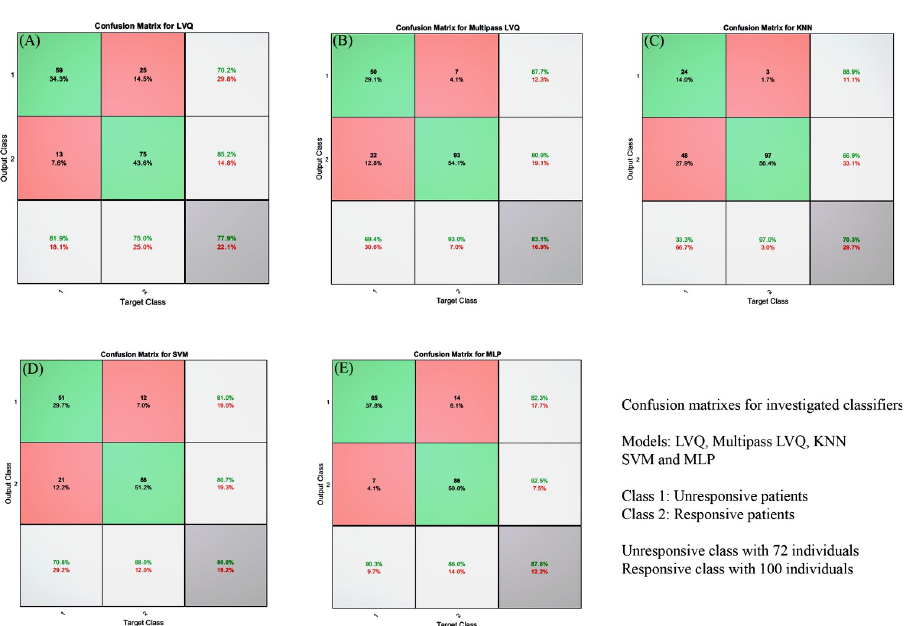
Fig 5. A, Confusion matrix for learning vector quantization neural network representing the performance of the model; B, Confusion matrix for multipass learning vector quantization neural network representing the performance of the model; C, Confusion matrix for multilayer perceptron neural network representing the performance of the model; D, Confusion matrix for support vector machine representing the performance of the model; E, Confusion matrix for k-nearest neighbors representing the performance of the